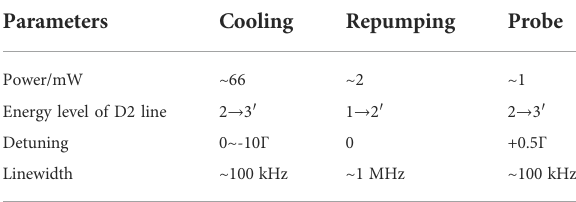
TABLE 1 The requirement of laser beams in the laser system with 87 Rb.